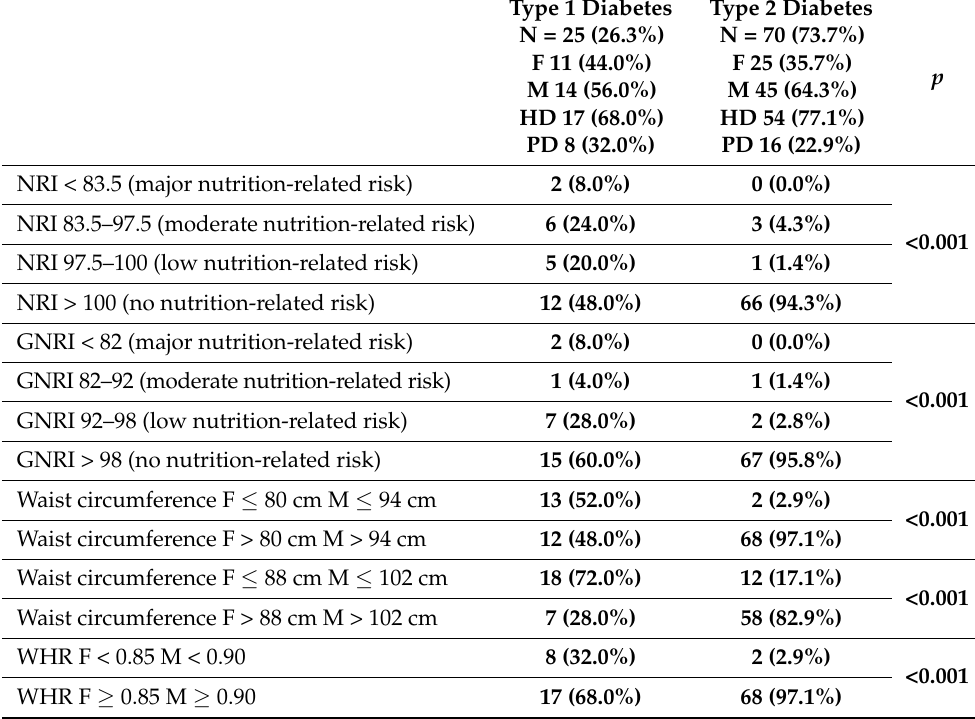
Table 2. The distribution of particular grades of nutrition and nutrition-related risk in different indices in the groups divided according to the type of